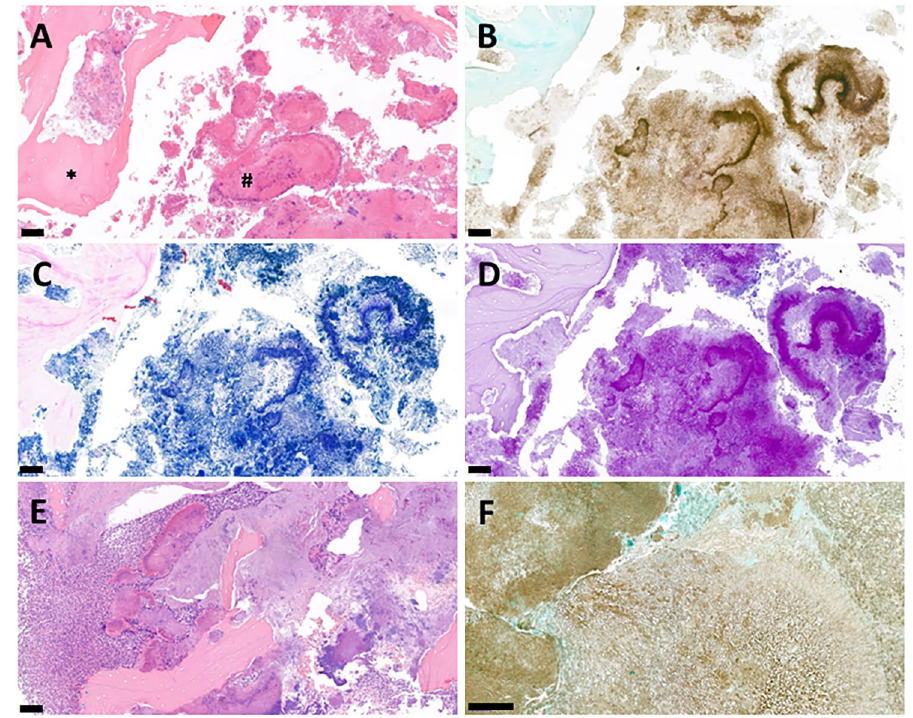
Figure 1. Histological characteristics of the MRONJ samples. ( A ) Histological appearance of a “positive” sample with necrotic bone trabeculae (*) and characteristic Actinomyces aggregates (#) on HE-stained section. ( B ) GMS- ( C ) Gram- and ( D ) PAS-stained sections from the same specimen showing the radial arrangement of the bacterial filaments. ( E ) Representative HE-stained section from a case with pronounced inflammatory infiltrate (left side) also containing rather uninvolved necrotic bone (right side). ( F ) A GMS-stained section of a specimen containing fungal hyphae as well. (Scale bar: A , B , C , D and E 100 μm; F 50